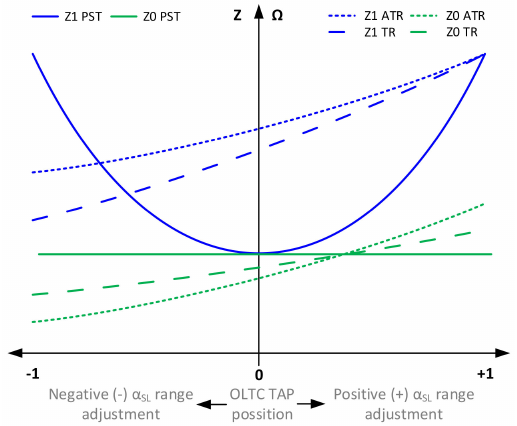
Figure 7. PST, ATR, and TR impedance in a function of the OLTC TAP position.